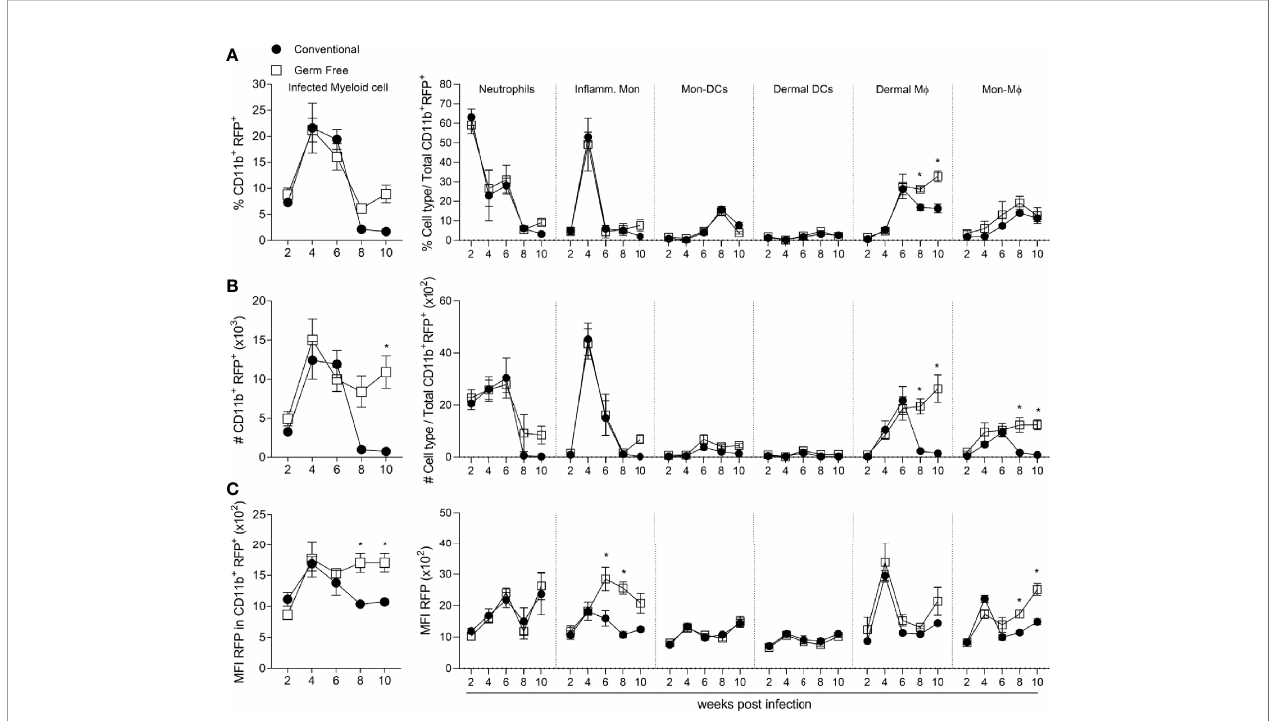
FIGURE 4 | Germ-free monocytes and macrophages remain infected after peak of infection. (A) Percentage of infected myeloid cells subsets in the footpad of infected mice 6-10 weeks after infection. (B) Absolute number (#) of infected myeloid cells and their subsets in the footpad of infected mice 2-10 weeks after infection. (C) MFI of RFP in infected myeloid cells and each immune cell subset in the footpad of infected mice 2-10 weeks after infection. * indicates statistical difference between groups of mice using two-way ANOVA and Bonferroni post-test (p < 0.05). Results are representative of two independent experiments. Four to 6 animals per group were used per